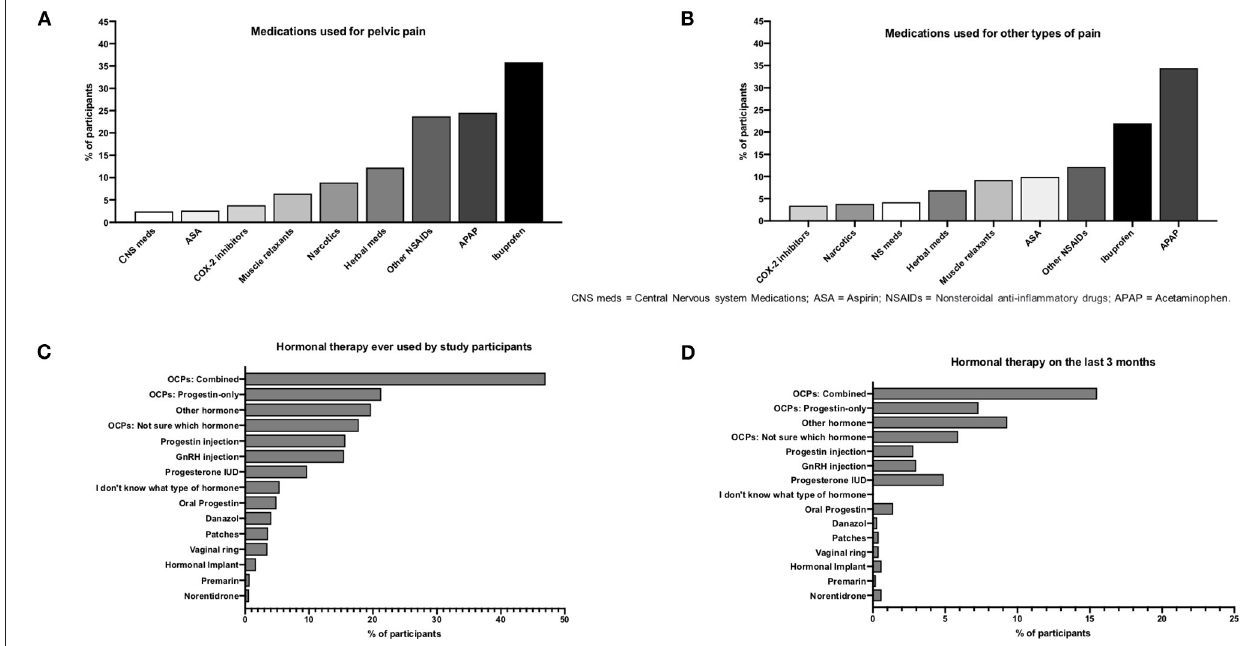
FIGURE 8 | Pain medications and hormonal therapies. (A) Medications used for pelvic pain. (B) Medications used for other types of pain. (C) Hormonal therapies ever used by participants. (D) Hormonal therapies during last 3